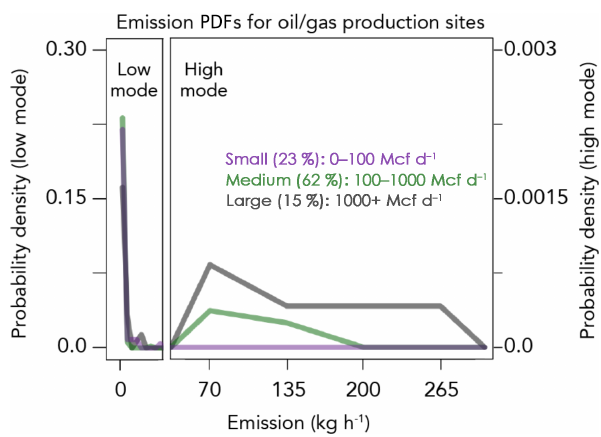
Figure 1. Probability density functions (PDFs) of emissions for oil/gas production sites of different production size categories (small, medium, and large) taken from Barnett Shale observations (Lan et al., 2015; Rella et al., 2015; Yacovitch et al., 2015). Note the difference in y -axis scales between the left (low mode) and right (high mode) panels. The axis break at 40kgh − 1 represents the threshold for flagging an emitter as high.